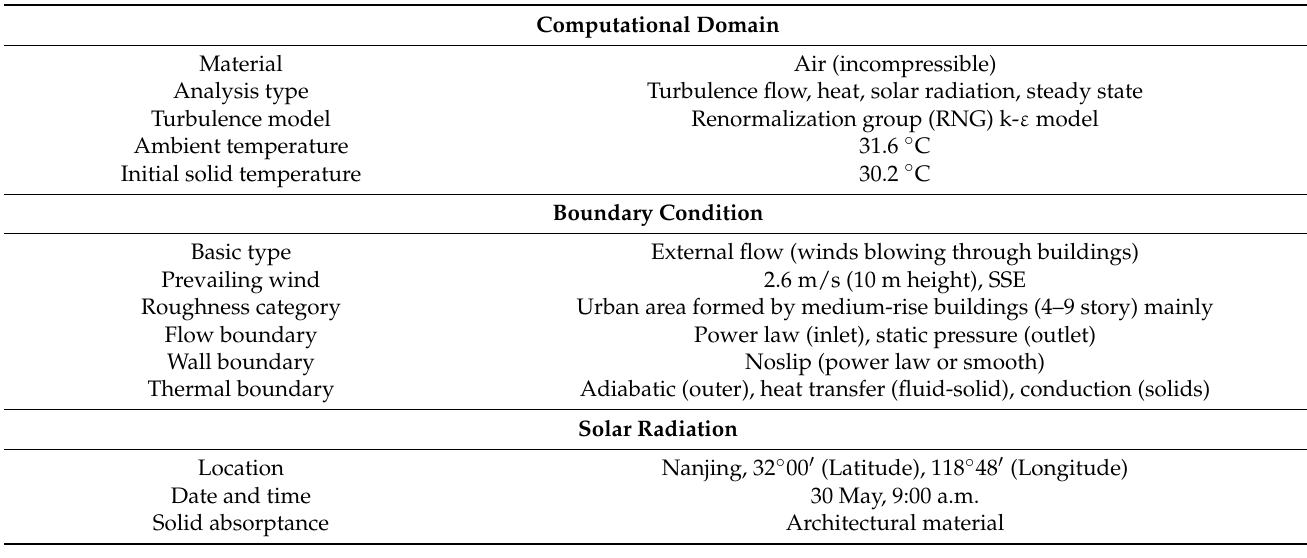
Table 5. Computational settings of CFD simulations.